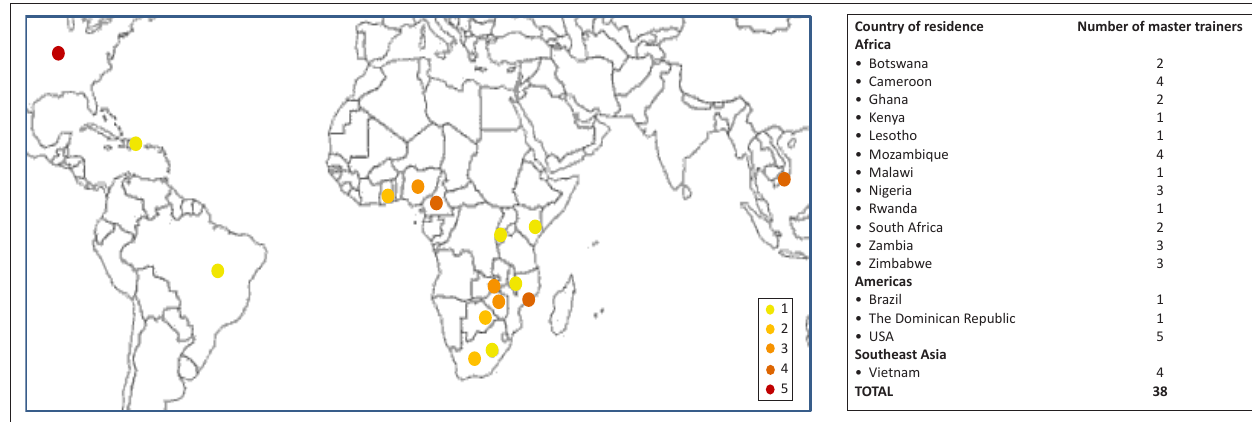
FIGURE 2 : Global distribution of SLMTA master